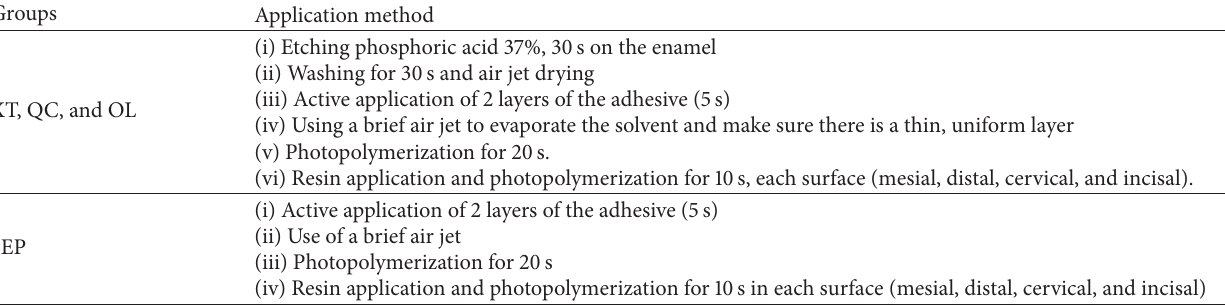
Table 2: Application methods of the adhesives systems used in this study.